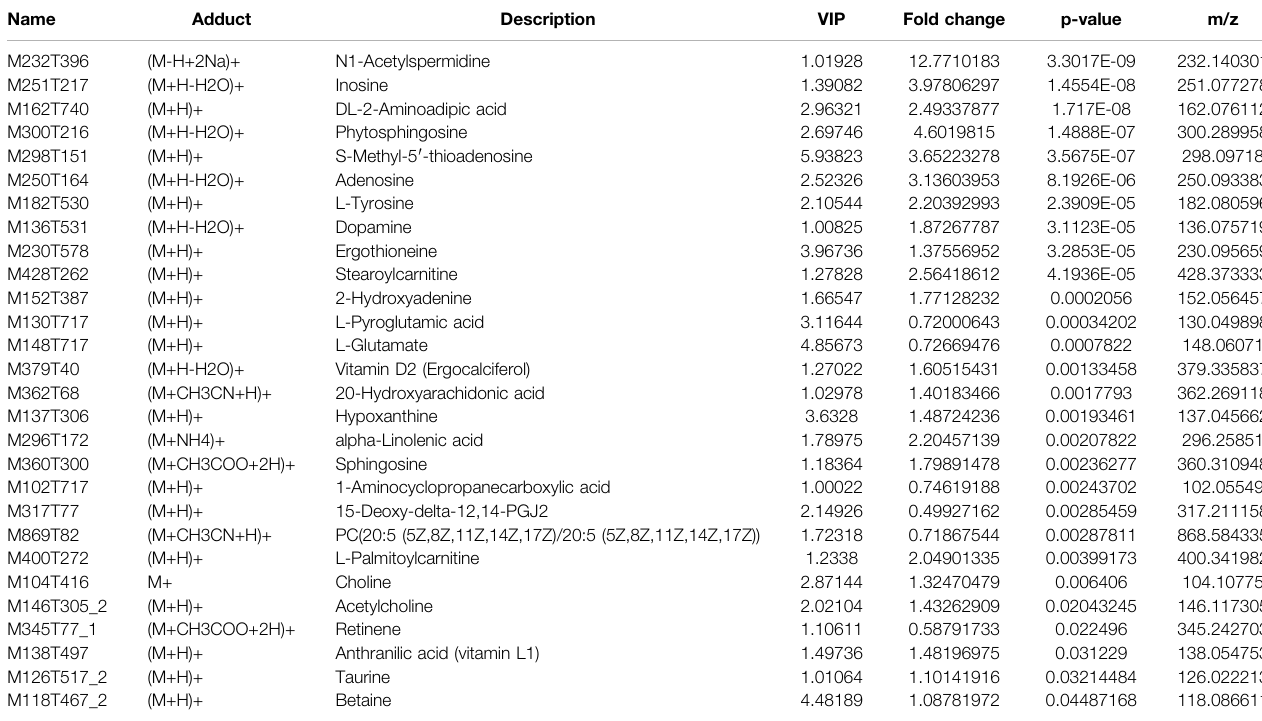
TABLE 3 | 28 signi fi cantly different metabolites in positive ion